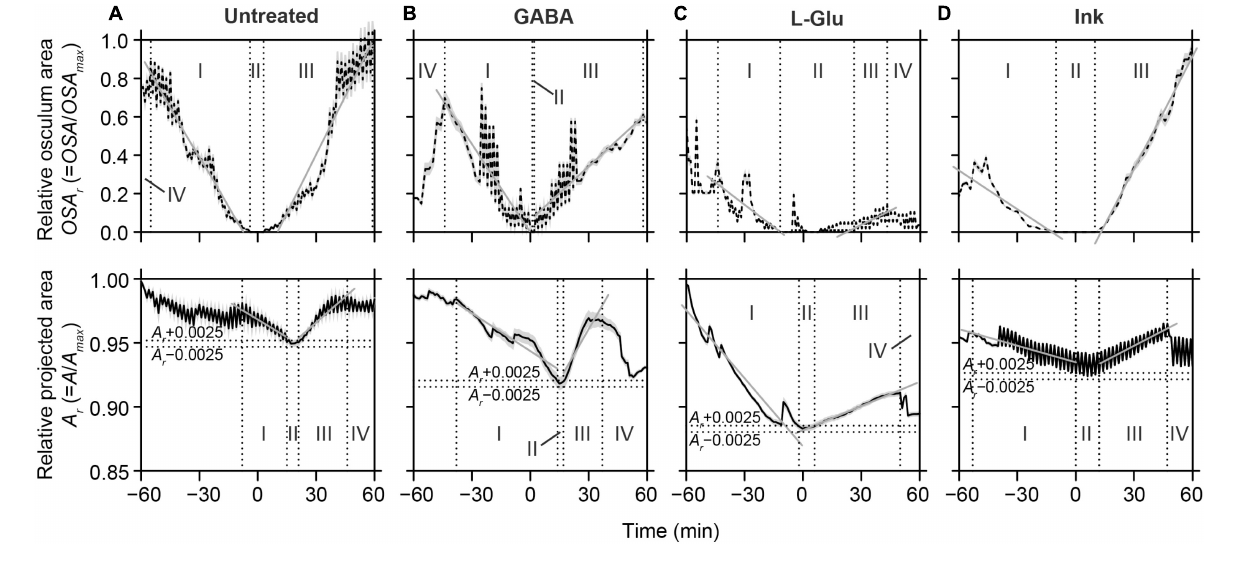
FIGURE 3 | Halichondria panicea . Spontaneous and induced contraction-expansion dynamics of single-osculum explants, expressed by changes in the relative osculum cross-sectional area and relative projected area (averaged over time ± 95% confidence intervals). Oscular contraction (I), closure (II) and expansion (III; upper panel) was accompanied by changes in projected area (lower panel), including contraction (I) to a minimum A min ± 0.0025, i.e. the contracted phase (II, horizontal broken lines), expansion (III) and a subsequent expanded phase (IV, vertical broken lines). Slopes of linear regressions (gray lines) indicate mean